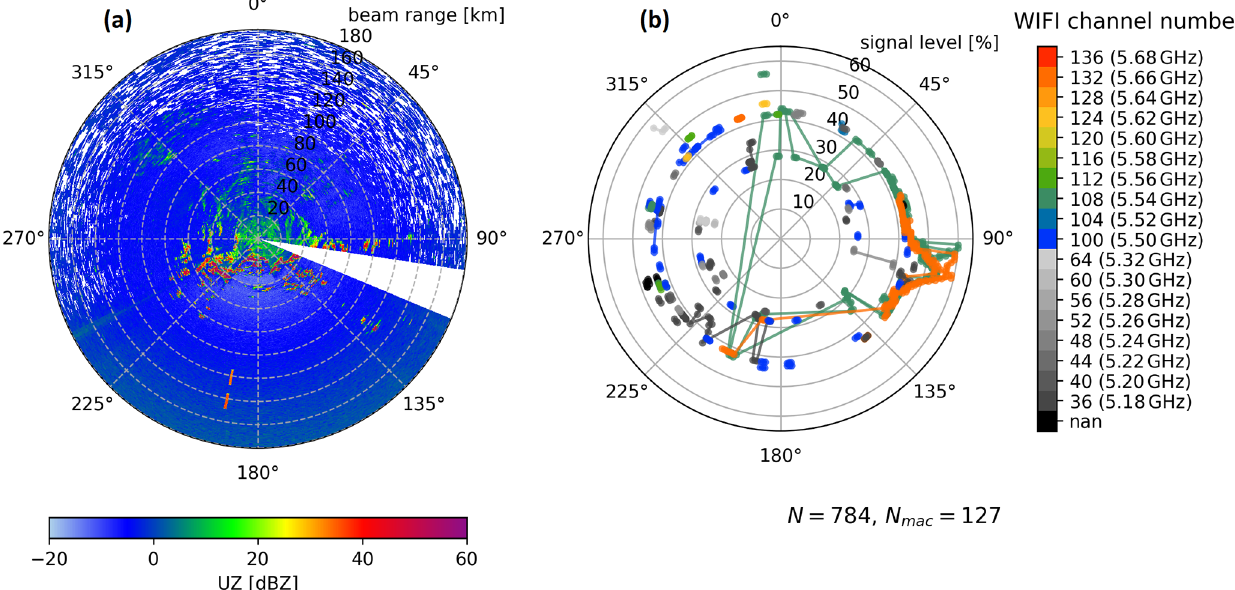
Figure 5. An uncorrected reflectivity (UZ) PPI is shown in panel (a) from the radar site MHP. It was taken after the RHunt sweep on 22 September 2021 at 18:22UTC. Panel (b) contains the identified Wi-Fi networks at their respective azimuth and signal level as dots. The Wi-Fi channel is colour coded. Channels above 100 (5500MHz, allowed outdoor) are coloured, and others are in greyscale. Each line connects networks with the same MAC address. In total 784 Wi-Fi records ( N ) and 127 networks with unique MAC addresses ( N mac ) were captured. Note the different variables on the radial axis.